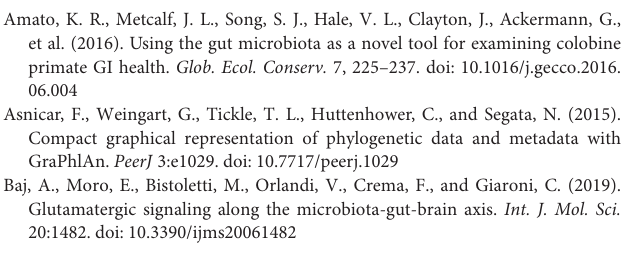
Supplementary Table 2 | Relative abundance of each taxonomy clade of each cohort ( A : CRr and WRr; B : CMm; C : Hum) analyzed in the study.